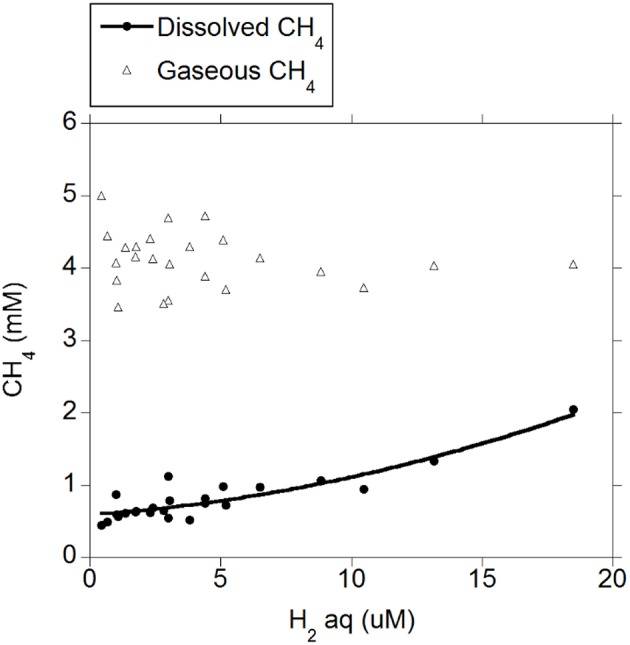
Relationship of dissolved H2 concentration with dissolved and gaseous CH4: CH4 (aq) = 0.54 (±0.049; P < 0.001) + 0.049 (±0.013; P < 0.001) H2 (aq) + 0.0027 (±0.0013; P = 0.056) (H2 (aq) – 4.42)2; R2 = 0.82 (P < 0.001); Gaseous CH4: CH4 (g) = 4.20 (±0.11; P < 0.001) − 0.016 (±0.019; P = 0.40) H2 (aq); R2 = 0.032 (P = 0.40).